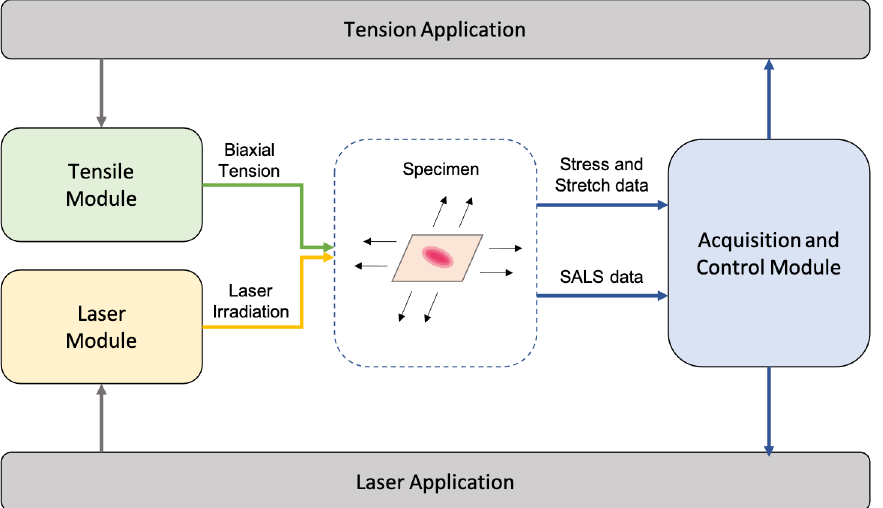
Figure 1. Schematics of the hardware modules and software applications of the OptiMech2 test